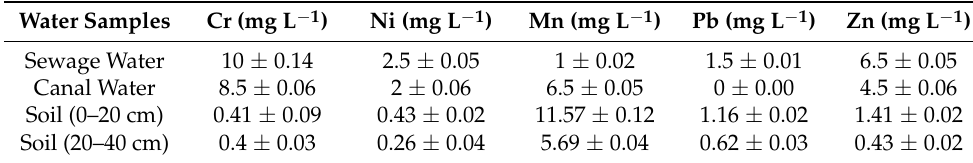
Table 4. HMs mean concentrations in water and